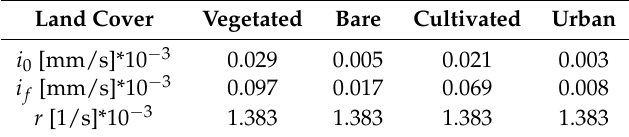
Table 2. Infiltration parameters of the Horton model for the different soil types